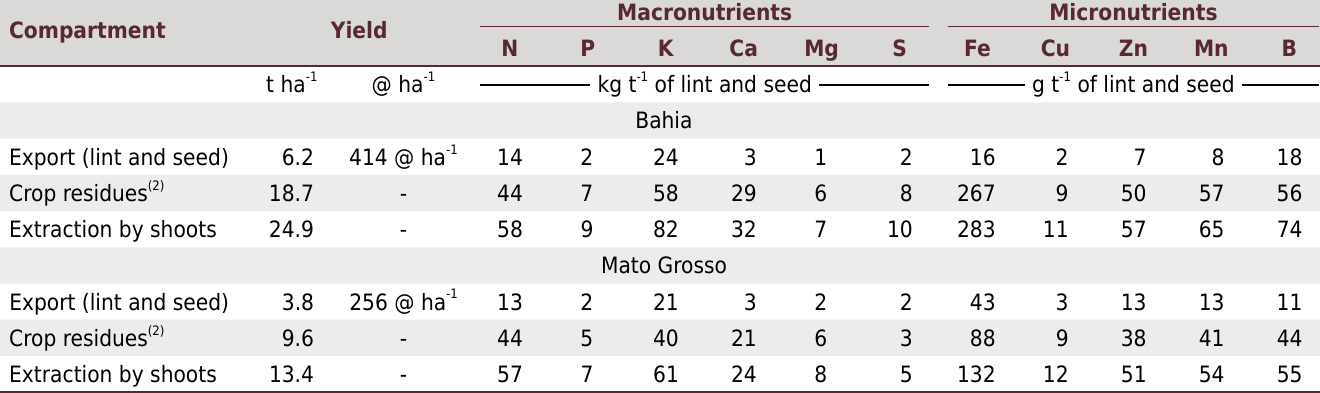
The values represent the average of three varieties in Bahia and two varieties in Mato Grosso. (2) Leaf, stem, and other constituents of the fruit (other than lint and seed). One @ represent 15 kg of lint and